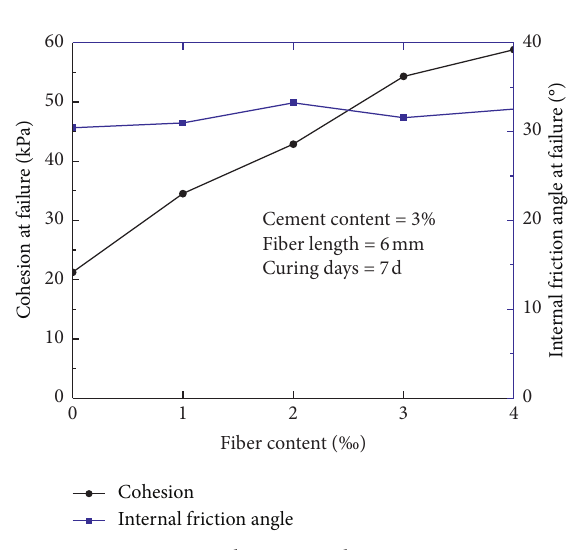
Figure 15: Shear strength